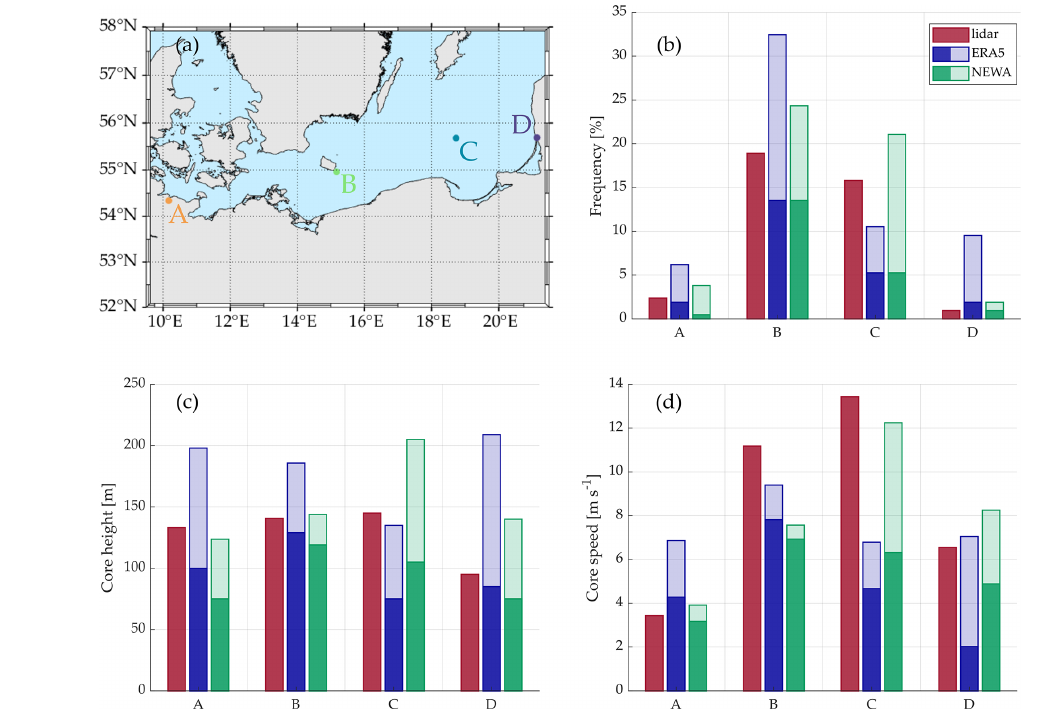
Figure 8. (a) Map with the four locations (A–D) where LLJ properties were calculated. Average values of LLJ frequency (b) , core height (c) , and core speed (d) at the four locations. The plain filled bars indicate the values obtained when a 300m profile is considered. The semi- transparent areas represent the increase when a profile of up to 500m is used for the calculation (only for the numerical